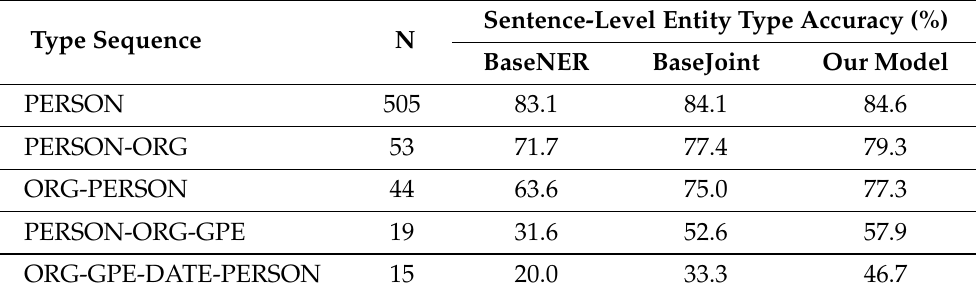
Table 11. Sentence-level entity type accuracy on specific entity type sequences. N is the number of samples containing the specific entity type